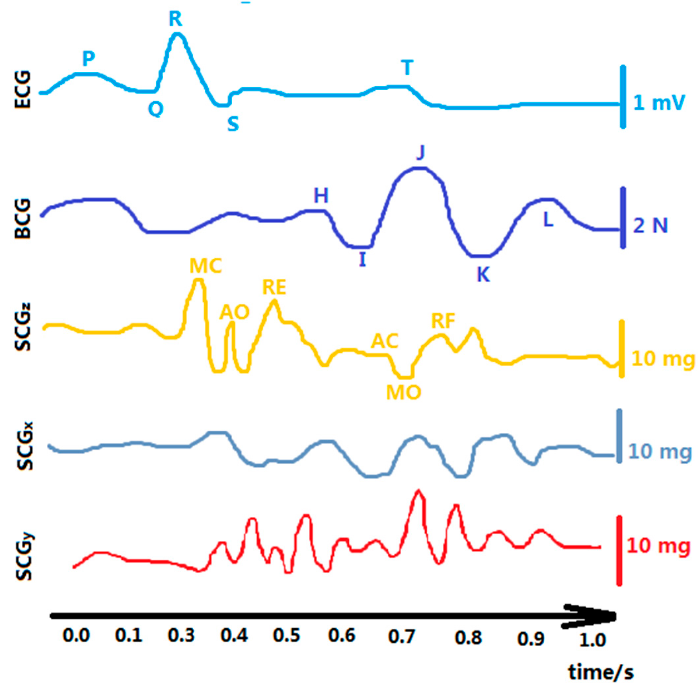
Figure 1. ECG/BCG/SCG